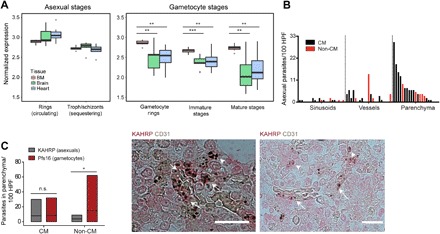
Asexual and gametocyte stages in the BM parenchyma of human malaria cases.(A) NanoString analysis of BM, brain, and heart tissue from patients who died of clinical cerebral malaria. Asexual P. falciparum parasite stages are predominantly sequestered in the brain and heart (left panel). All gametocyte-specific transcripts are significantly enriched in BM compared to the other tissues (right panel). Data were normalized on the basis of background subtraction and expression of housekeeping genes. **P < 0.01 and ***P < 0.001. (B and C) Quantification of immunohistochemistry (IHC) studies on human autopsy cases from BM tissue (n = 22). (B) Quantification of IHC with KAHRP antibodies to mark asexual P. falciparum parasites and CD31 to mark vasculature (HPF, high-powered fields). Histogram demonstrated that presence of parasites in BM is highest in the parenchyma compared to sinusoids and vessels. (C) Patients succumbing in absence of cerebral malaria (CM) had higher numbers of gametocytes (Pfs16) in parenchyma than asexual parasites (KAHRP), whereas these numbers were similar in CM patients. Representative IHC images of CD31 (brown) and KAHRP (red) from a human autopsy BM sample are shown. Arrows indicate intravascular asexual parasites, and arrow heads indicate extravascular asexual parasites. *P < 0.05. Scale bars, 20 μm.